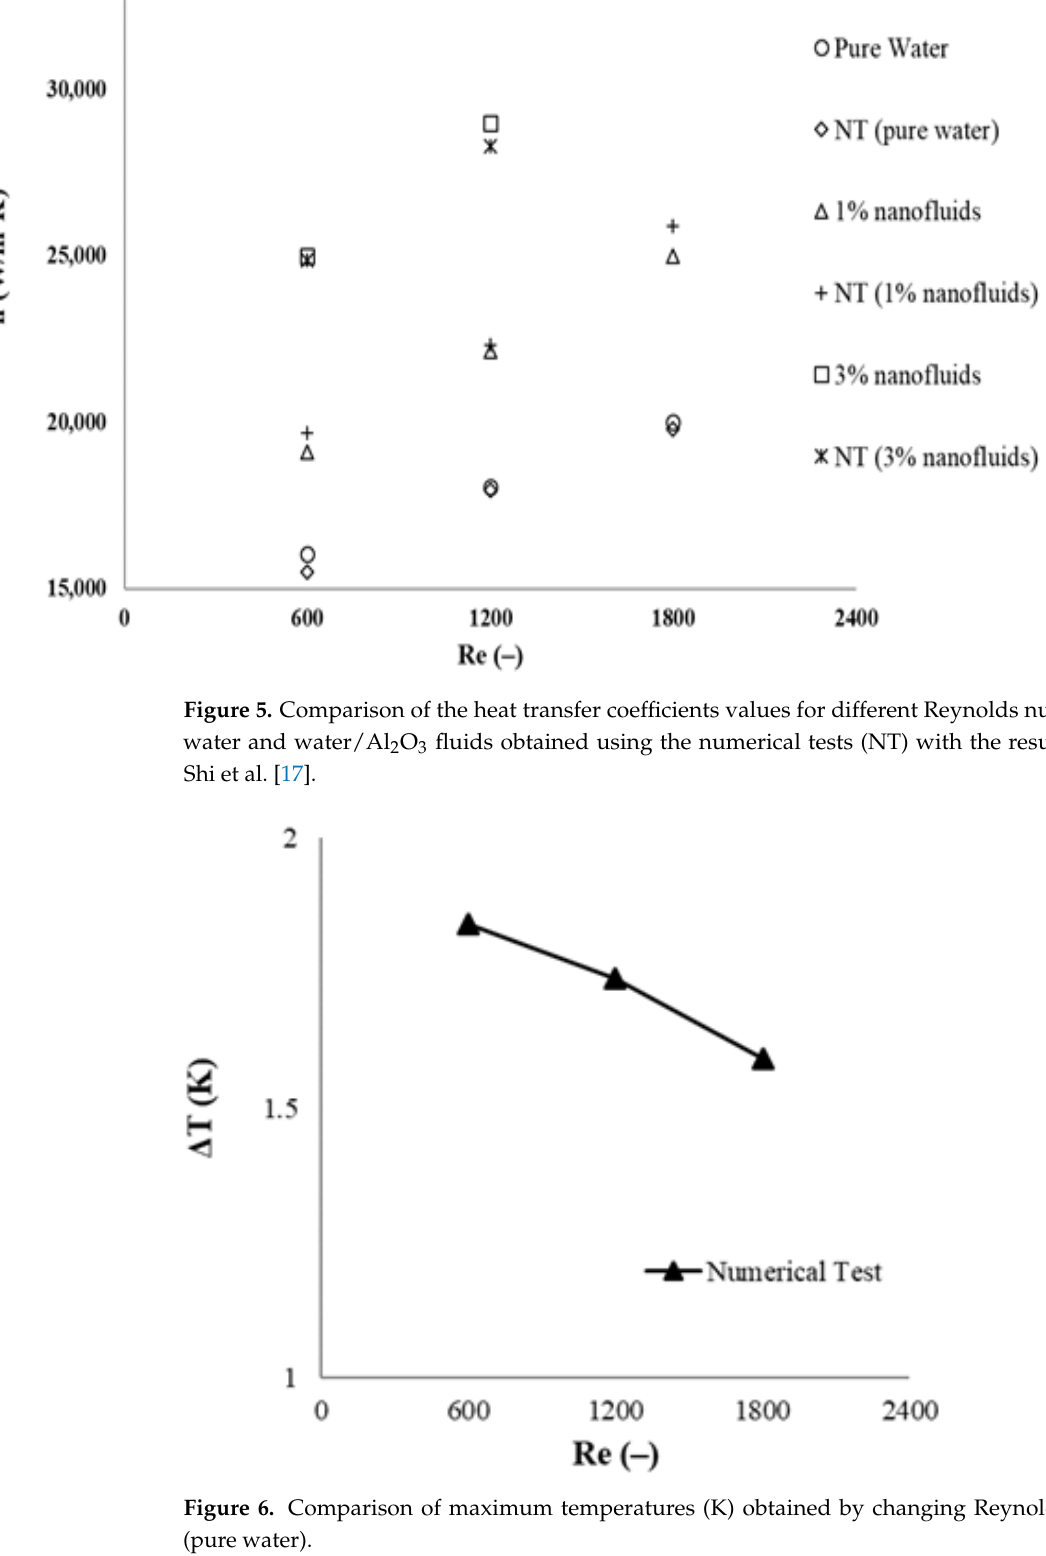
Figure 7. Comparison of the temperature contour (K) obtained numerically for pure water with Re = 600, 1200 and 1800, respectively.